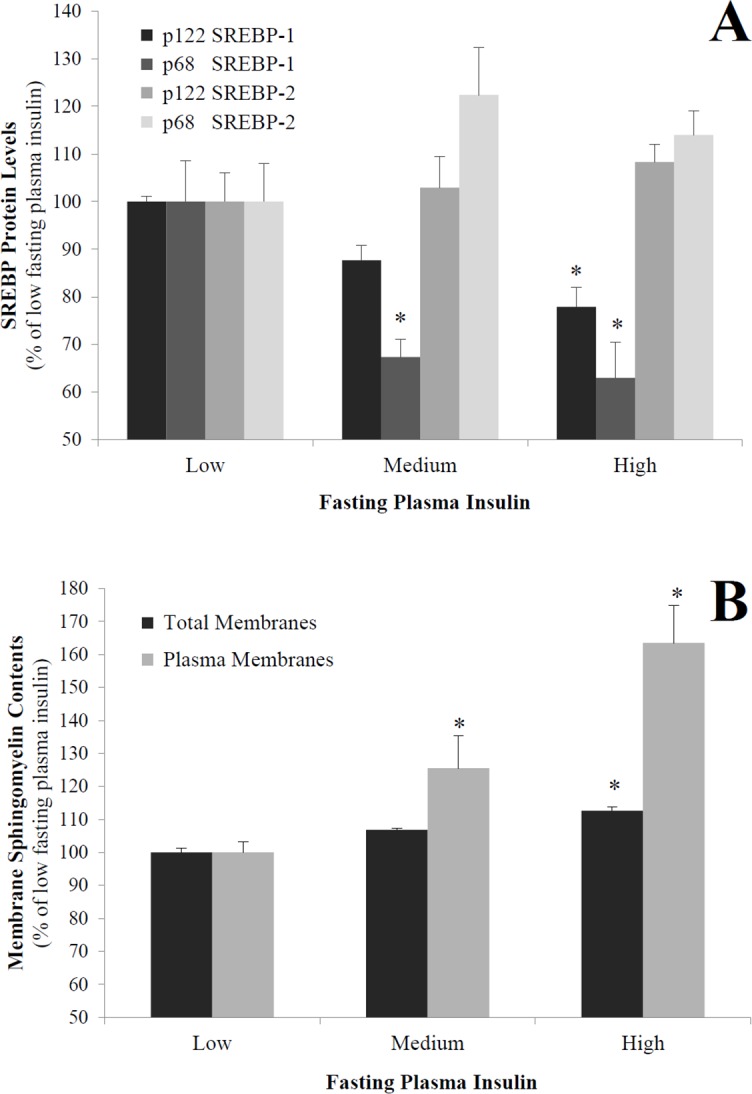
Levels of SREBP proteins (A) and sphingomyelin in total and plasma membranes (B) in human adipose tissue.In total, 23 obese women were grouped into tertiles according to their fasting plasma insulin (FPI) concentrations. Mean FPI±SEM (mU/L): low, 10.5±2.1; medium, 17.6±1.3; and high, 36.2±4.1. The results are expressed as percentages of low FPI cells. Cell lysates were separated by SDS-PAGE and immunoblotted with antibodies reacting with both precursor (p122) and cleaved active (p68) proteins of SREBP-1 or SREBP-2 (100 μg of protein). Total and plasma membranes were prepared, and sphingomyelin concentrations were determined as described in the Materials and methods. *
P<0.05; high or medium FPI compared with low FPI.